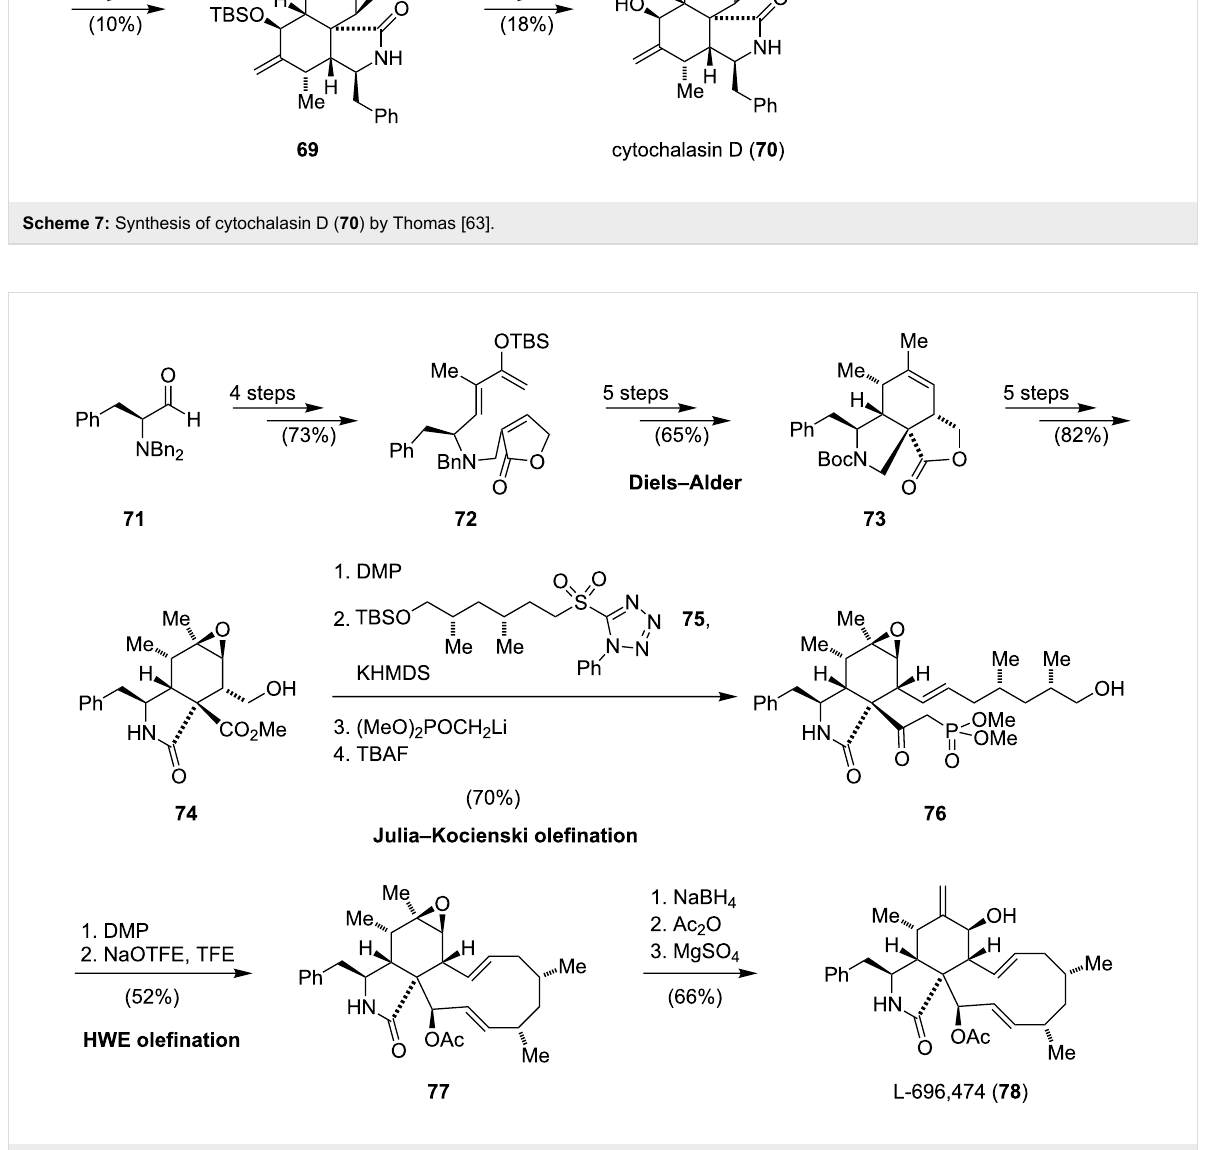
Scheme 8: Synthesis of L-696,474 ( 78